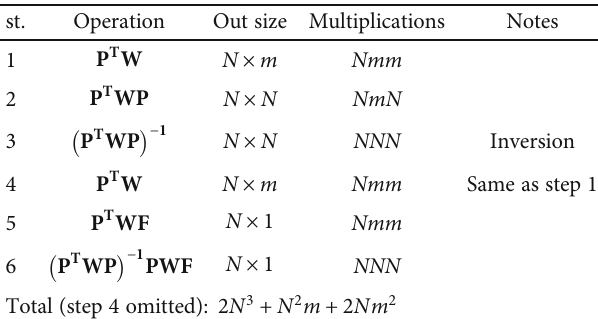
Table 2: Computation load of steps in calculating coe ffi cients of vector a according to Equation (12).